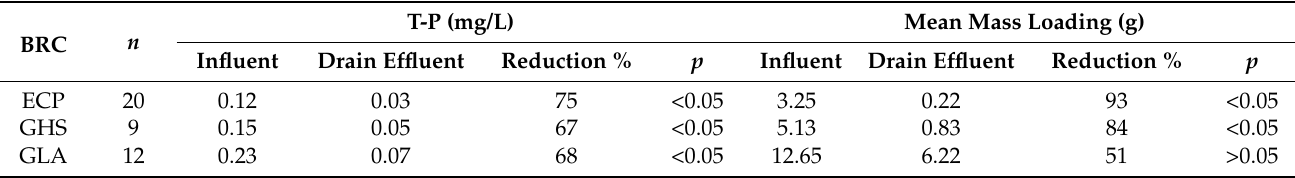
Table 4. Stormwater and drain mean T-P concentration, mean mass loading, number of storms sampled ( n ), and Wilcoxon Rank-Sum Test significance of difference between influent and drain ( p